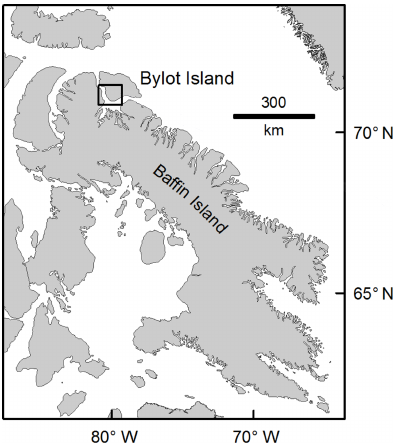
Figure 1. Location of the study site in the southwest plain of Bylot Island in the Canadian Arctic